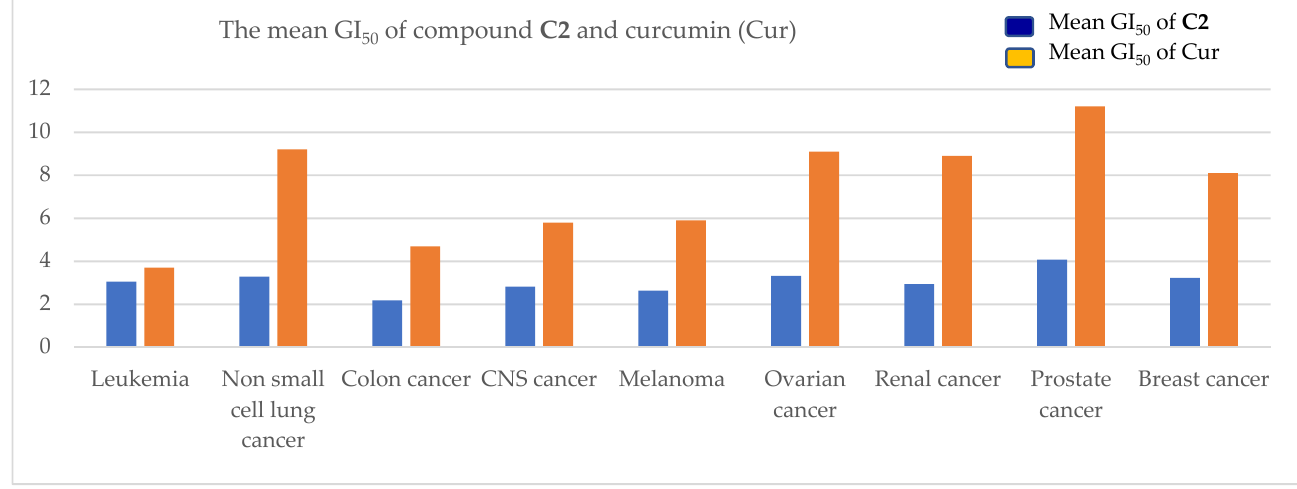
Figure 3. The percent growth inhibition of compounds C1-C3 in single dose assay against 59 NCI cancer cell lines.